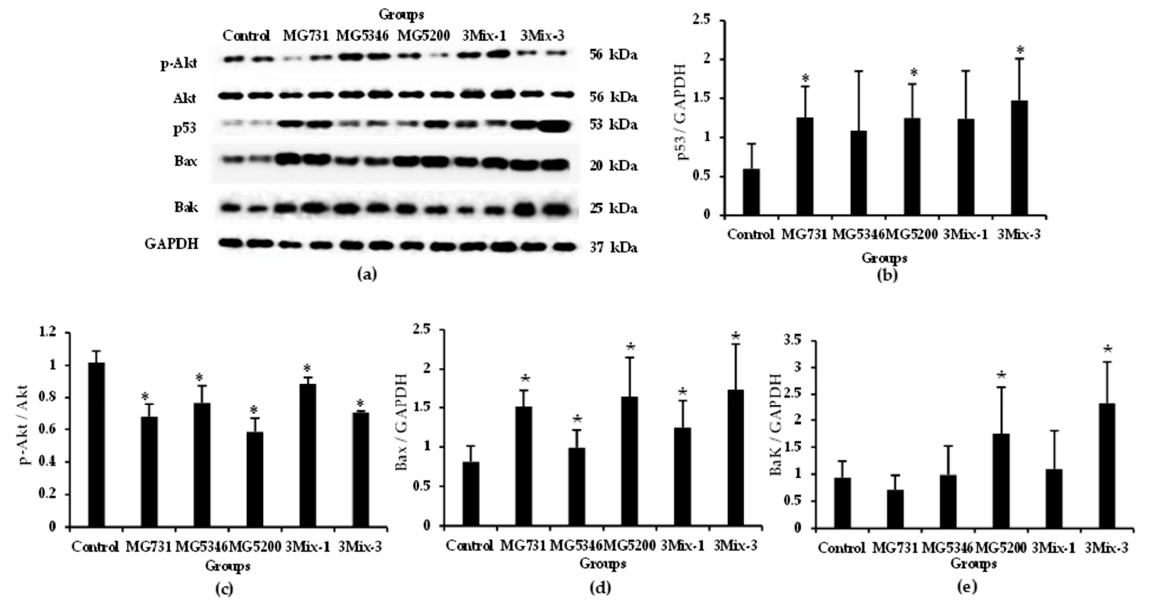
Figure 4. Expression of apoptosis-related proteins in tumor tissues from xenograft model analyzed by Western blotting. After 19 days of administration, proteins were extracted from the tumor tissues and subjected to Western blotting. ( a ) The representative Western blot images; Western blot quantitative data of ( b ) p-Akt/Akt, ( c ) p53/GAPDH, ( d ) Bax/GAPDH, and ( e ) Bak/GAPDH. Results are presented as the mean ± SD ( n = 6). * p < 0.05 compared with the control group.